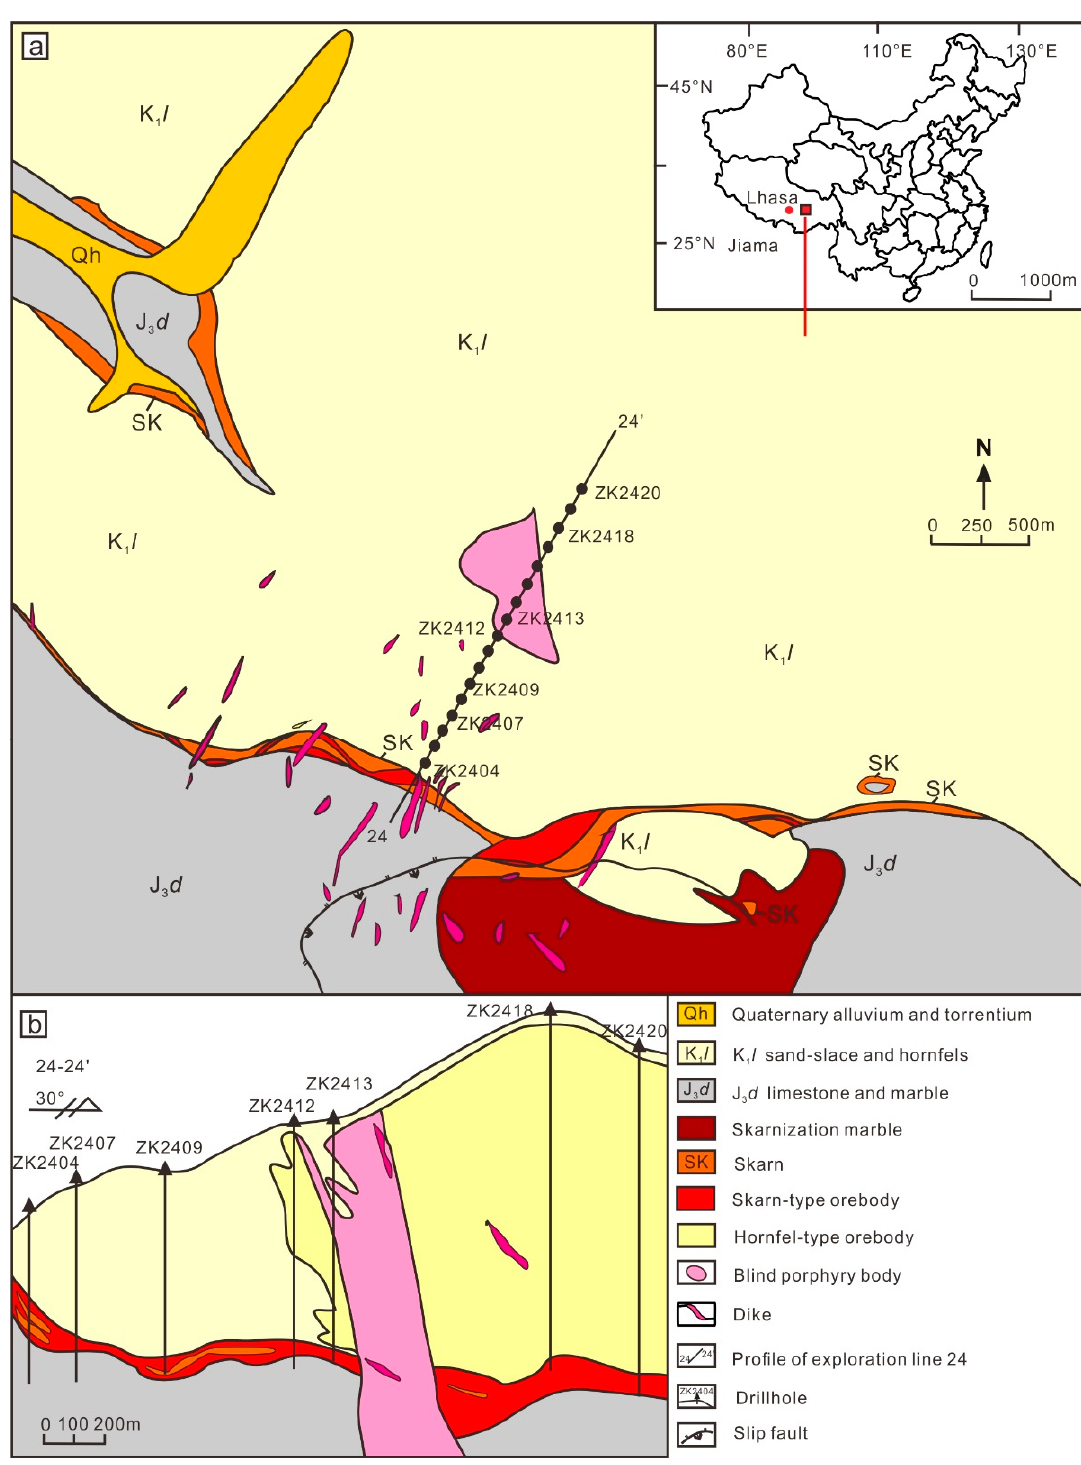
Figure 1. ( a ) Geological map of the Jiama deposit mining area. ( b ) Profile of the No.24 exploration line (modified according to [29]).